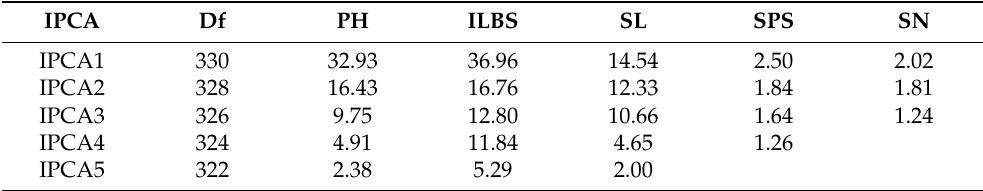
Table 5. Principal component analysis of genotypes-by-environments ( F